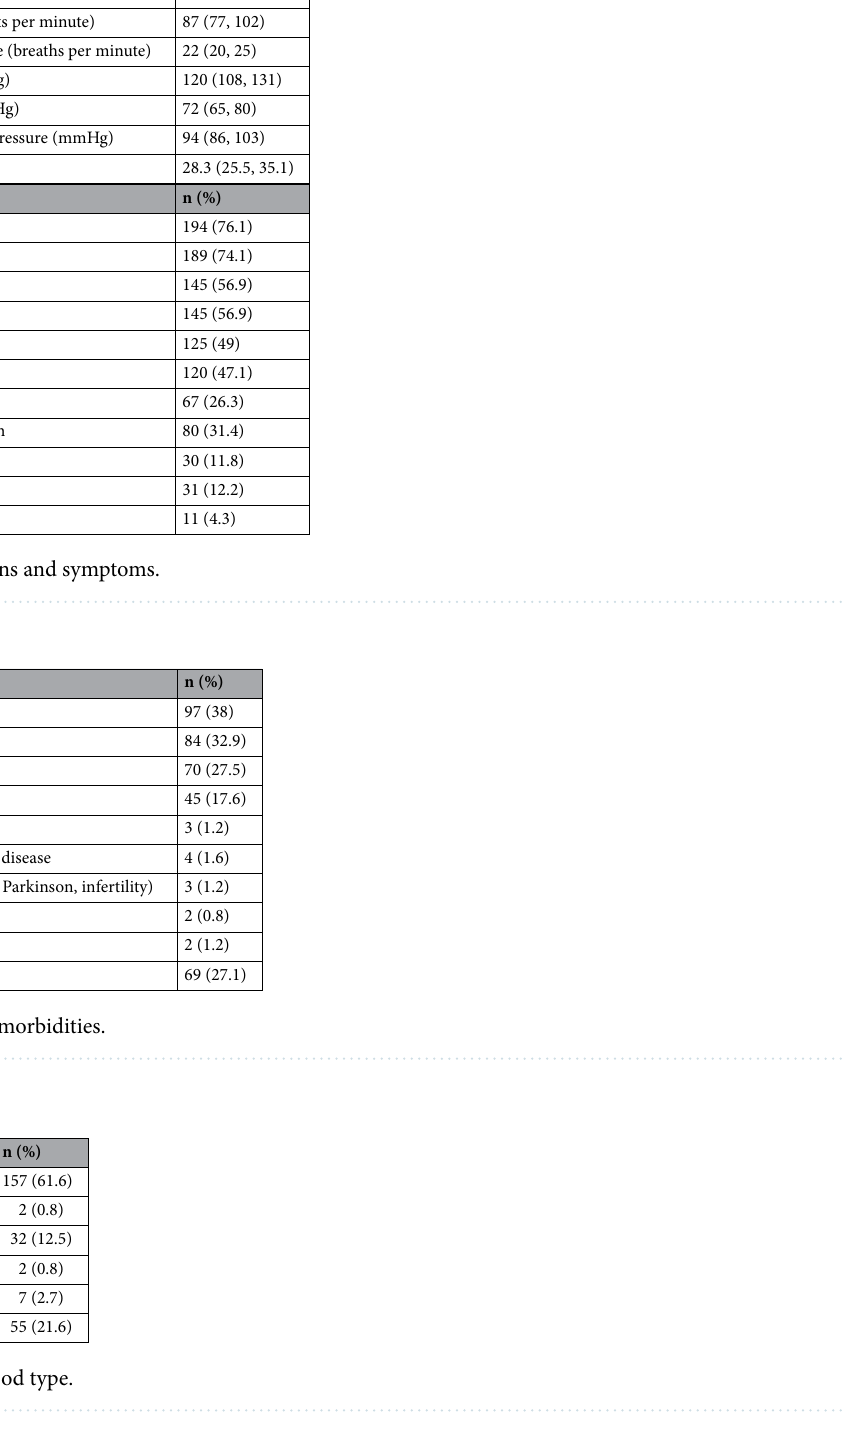
FTIR analysis. Figure 1A shows saliva FTIR spectra of COVID-19 (red spectrum) and healthy (blue spec- trum) groups, where diverse absorption bands related to different biomolecules are evidenced, such as lipids, proteins, carbohydrates, and nucleic acids, usually present in biological samples. The average saliva spectrum of both groups showed characteristics of biological samples, peaks of proteins at 1644 cm −1 (Amide I, C=O stretch- ing), 1545 cm −1 (Amide II, N–H bending), and 1240 cm −1 (Amide III) were evidenced. Besides, in the region of nucleic acids (1100–850 cm −1 ), P=O asymmetrical and symmetrical stretching vibrations of PO 2 phosphodiester groups from phosphorylated molecules (1240 cm −1 and 1076 cm −1 ) were also observed, as well as C–O stretch-